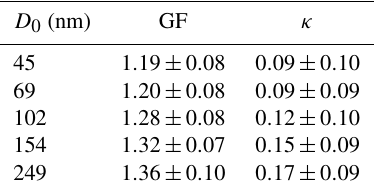
Table 1. Mean peak growth factors and derived κ from HTDMA measurements for each dry diameter, along with ± standard devia- tion.